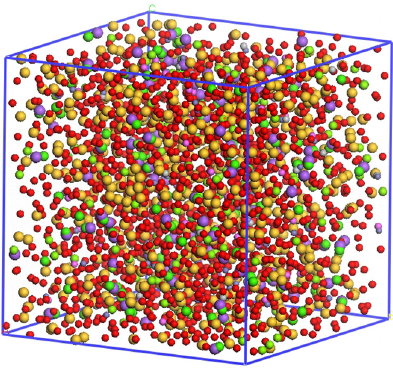
Figure 1. Cubic box of a molten red mud system. Figure 1. cubic box of a molten red mud system. Table 3. Number of atoms in molecular dynamics.